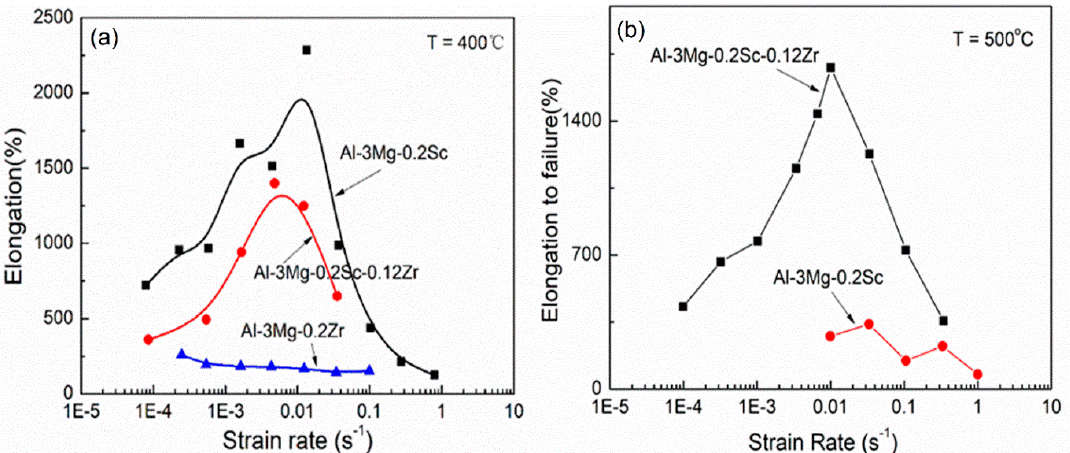
Figure 10. Elongation to failure vs. strain rate reproduced from [112], with permission from Elsevier, 2002: ( a ) Elongation to failure versus initial strain rate for the alloys tested at 400 °C; ( b ) Elongation to failure versus initial strain rate for the Al-Mg-Sc-Zr and Al-Mg-Sc alloys tested at 500 °C.